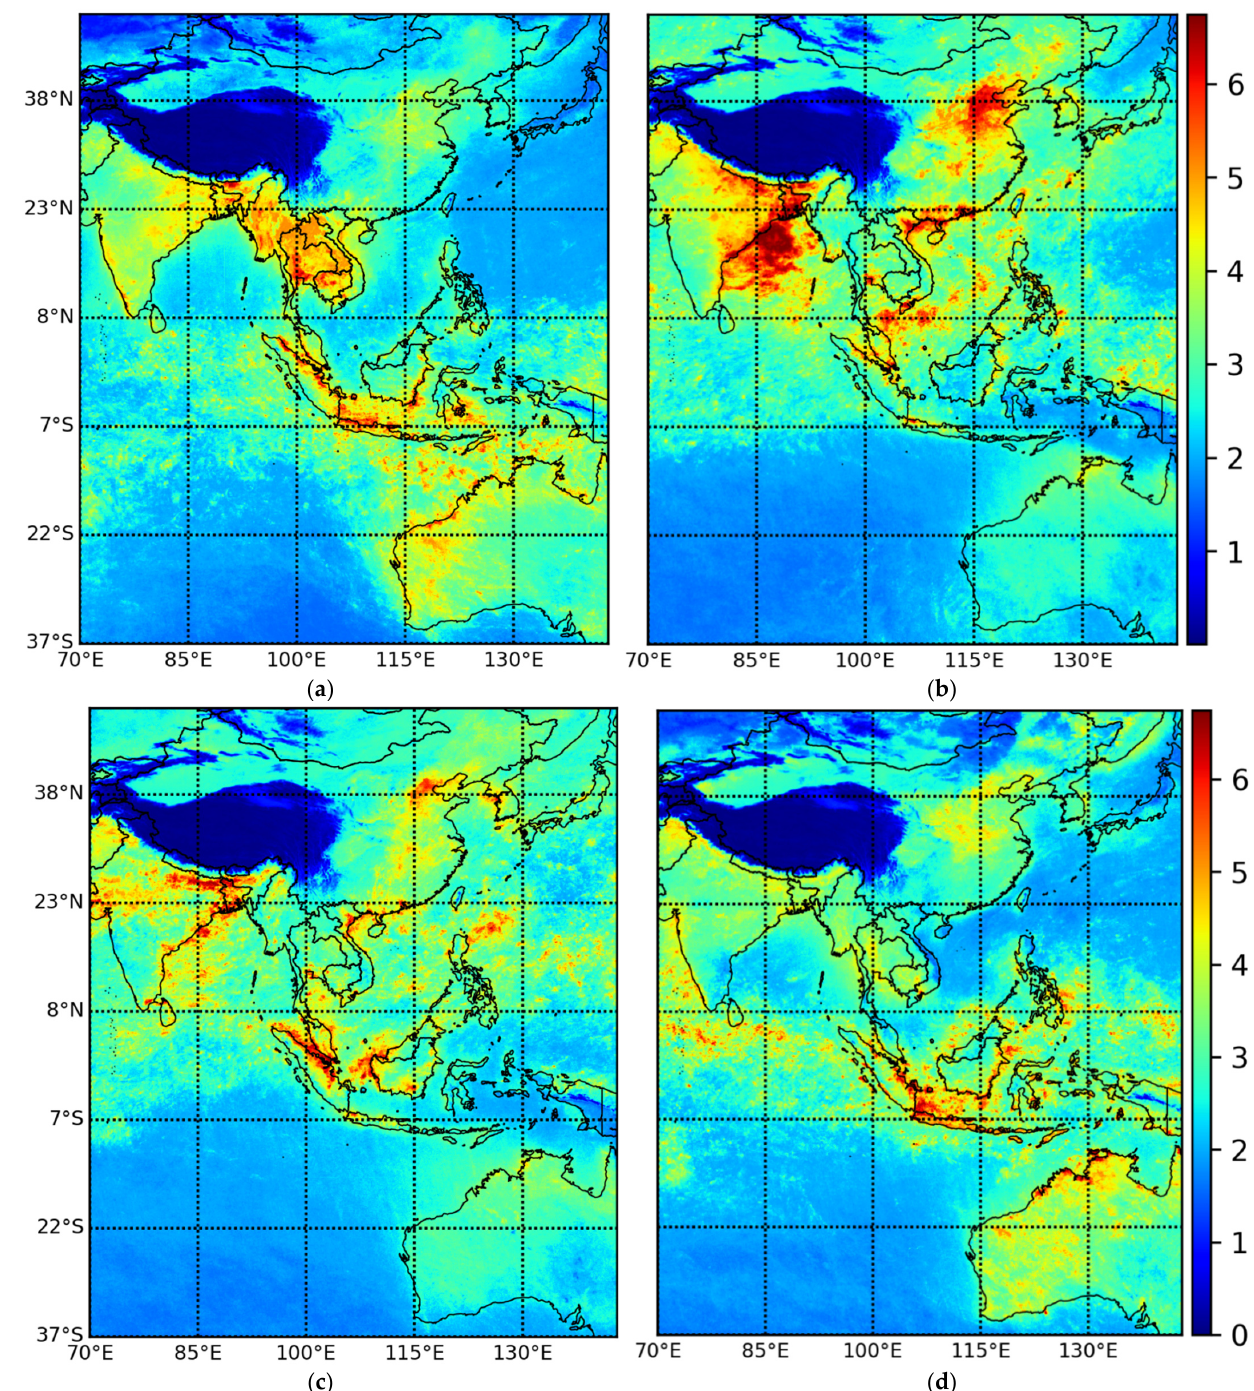
Figure 13. Surface concentration of HCHO in Indo-Pacific region in some typical months: ( a ) March; ( b ) June; ( c ) September; ( d ) December. (unit: μ g/m 3 ).